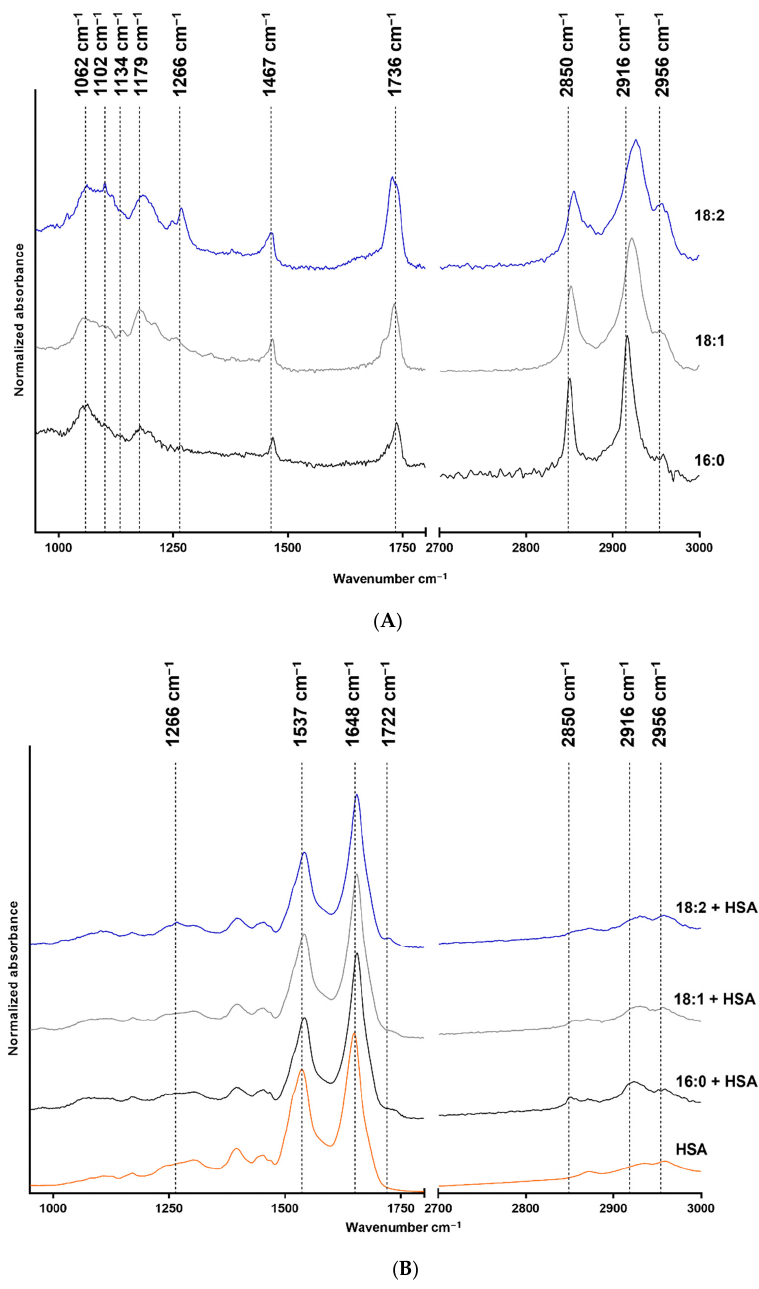
Figure 1. FTIR spectra of native and HSA-bound LPA species and native HSA. ( A ) Native 16:0 LPA is shown at the bottom, 18:1 in the middle, and 18:2 at the top of the image. ( B ) The bottom line shows the FTIR spectra of native HSA and, in a vertical sequence, HSA-bound 16:0, 18:1, and 18:2 LPA species are shown.